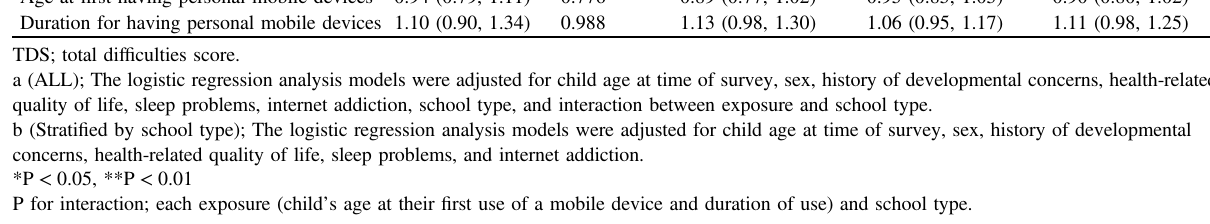
Table 5 OR for child behavioral problems (TDS) according to child ’ s mobile device usage. Exposure